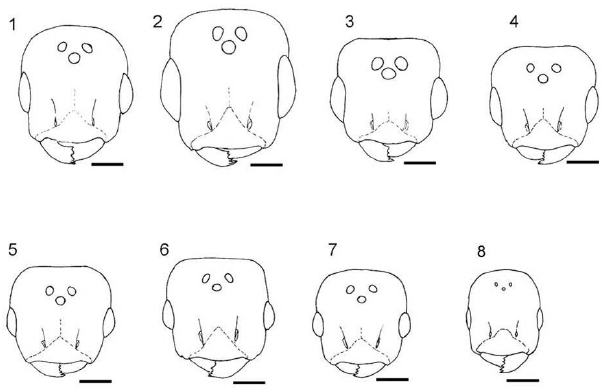
Fig 3. Queens of Macaranga -associated Crematogaster ( Crematogaster borneensis -group) species in full-face view. 3.1: Crematogaster borneensis ; 3.2: Crematogaster linsenmairi ; 3.3: Crematogaster captiosa ; 3.4: Crematogaster claudiae ; 3.5: Crematogaster hullettii ; 3.6: Crematogaster decamera; 3.7: Crematogaster maryatii ; 3.8 Crematogaster roslihashimi . Scale bar corresponds to 0.4 mm.